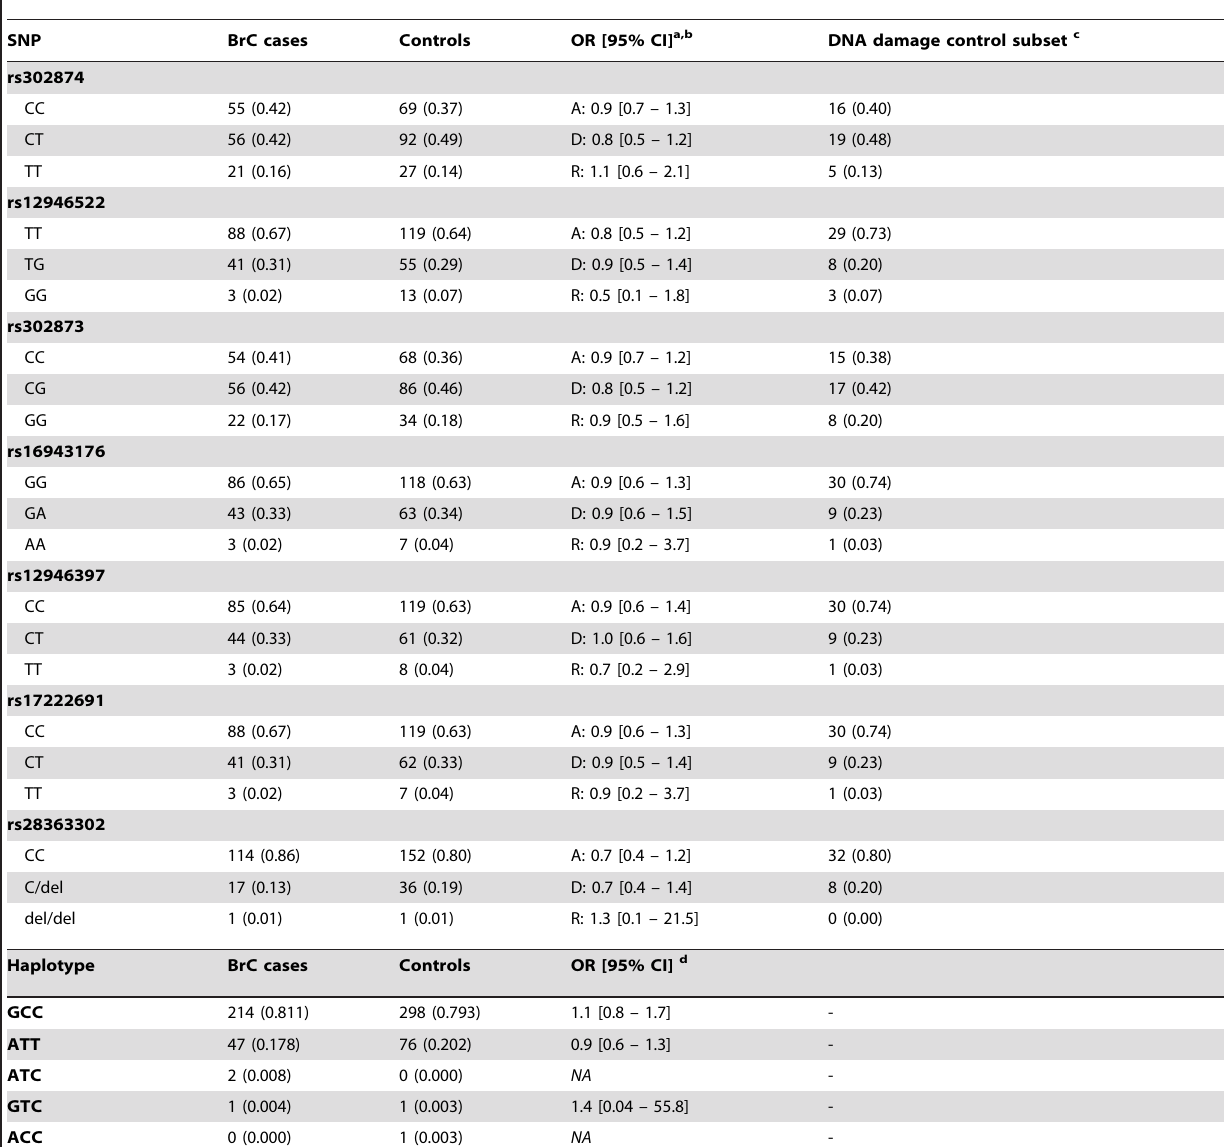
Table 3. Observed frequencies of genotypes and haplotypes reconstructed based on SNPs located within the LD block identified in RAD51C , together with respective odds ratios (OR) and corresponding 95% confidence intervals in BrC cases and healthy controls.